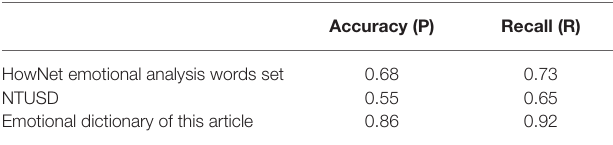
TABLE 4 | Evaluation of the performance of each dictionary sentiment classification